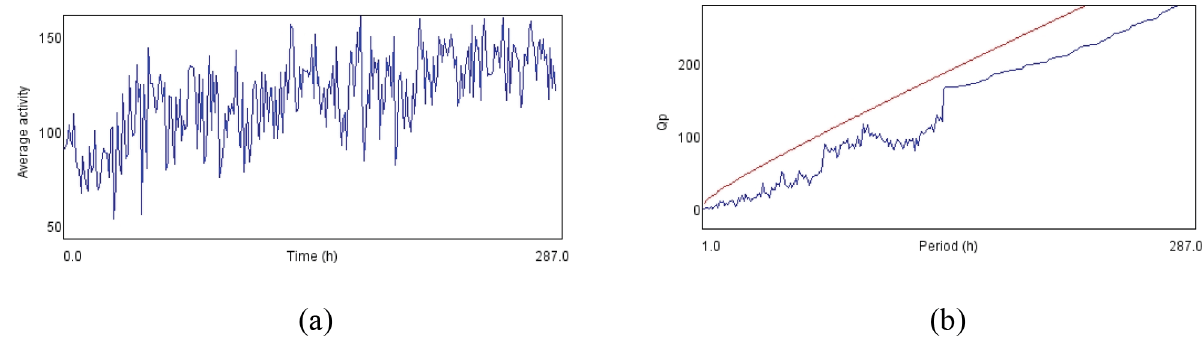
FIGURE 7S - (a) and (b) shows the average activity pattern and chi-square periodogram respectively for PD flies exposed to luteolin (75